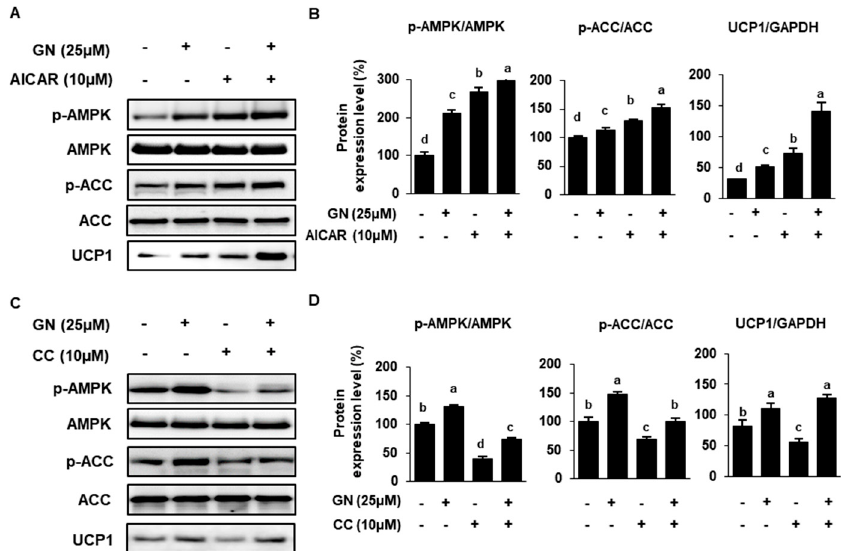
Figure 4. E ff ects of AMPK activation in 3T3-L1 cells treated with GN. ( A , B ) 3T3-L1 cells were treated with 10 µ M AICAR ± 25 µ M GN, and e ff ects on protein phosphorylation and / or expression were determined by Western blotting. ( C , D ) 3T3-L1 cells were treated with 10 µ M CC ± 25 µ M GN, and e ff ects on protein phosphorylation and / or expression were determined by Western blotting. Protein data are expressed as mean ± SD ( n = 4). Values with di ff erent letters are significantly di ff erent, p < 0.05 (a > b > c > d). AICAR; 5-aminoimidazole-4-carboxamide ribonucleotide, CC; Compound C, 6-[4-(2-Piperidin-1-yl-ethoxy)-phenyl)]-3-pyridin-4-yl-pyrrazolo[1,5-a]-pyrimidine.